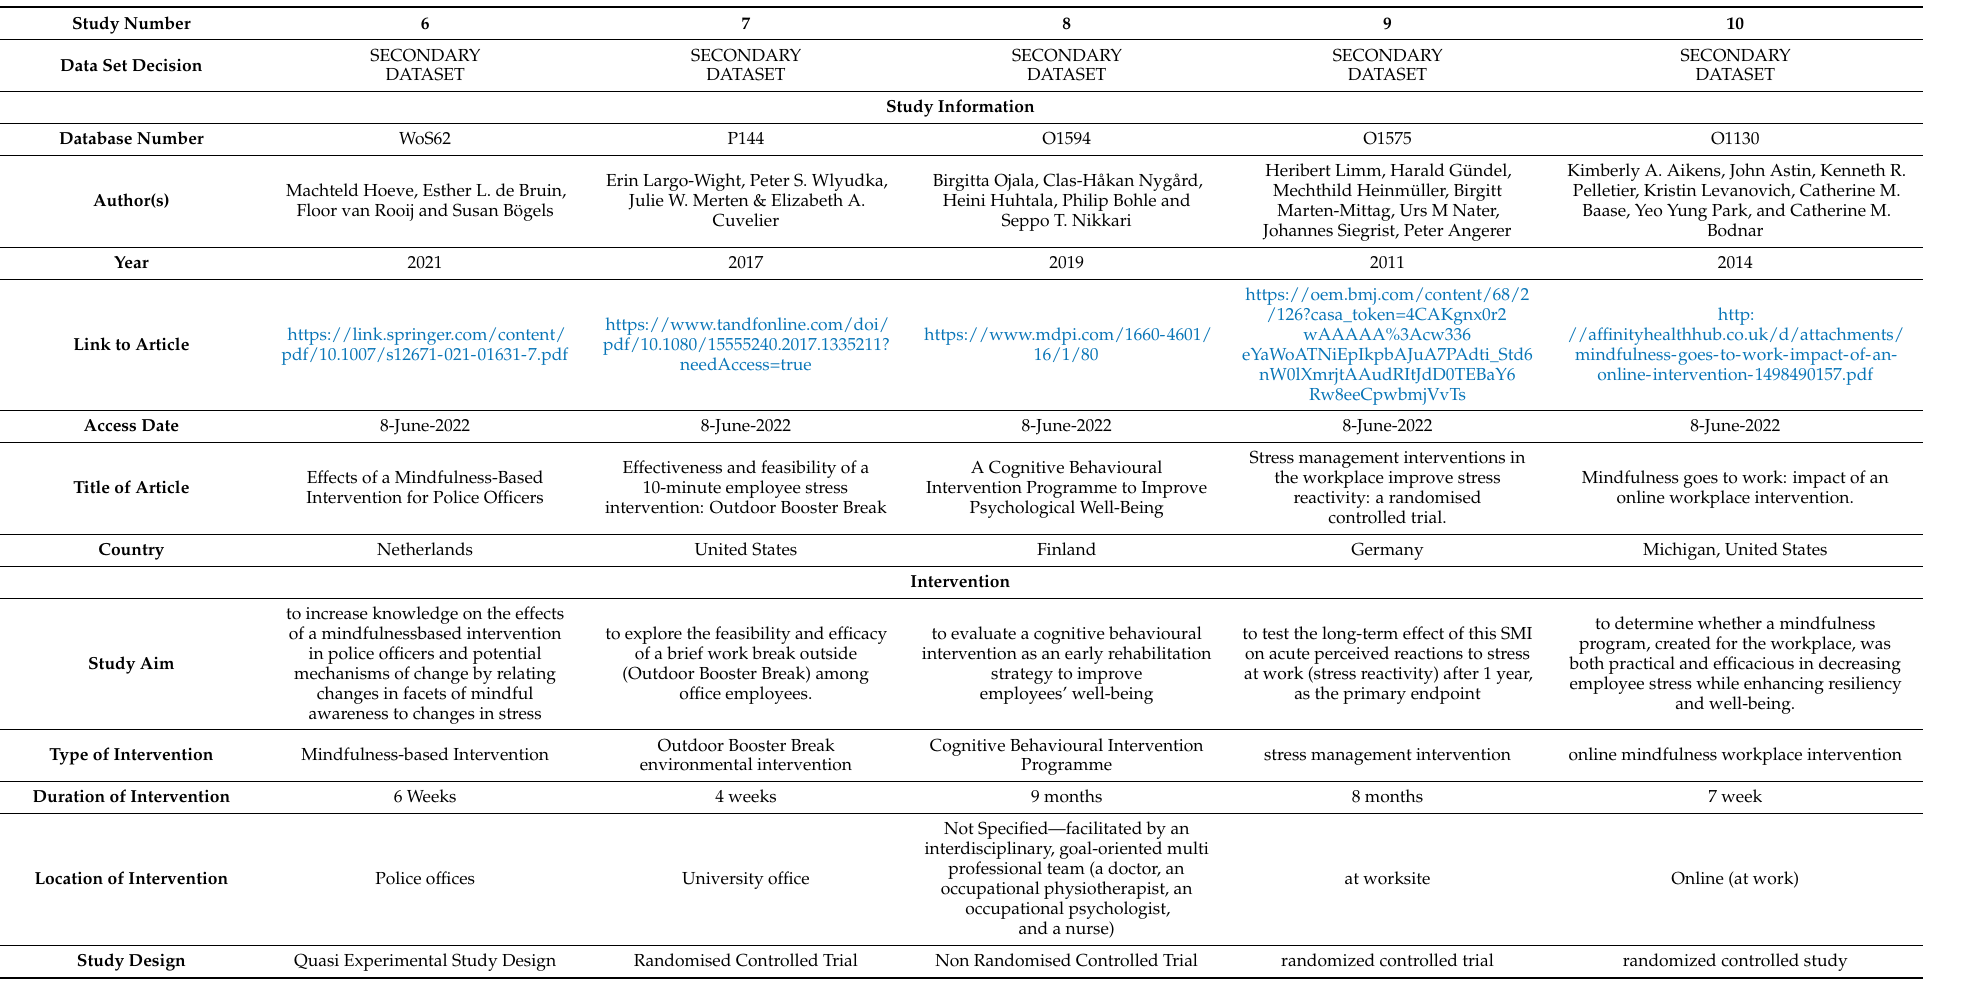
Table A2. Data Extraction Form from Secondary